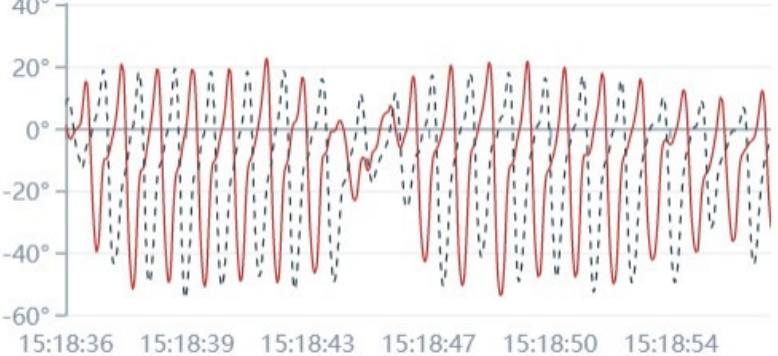
Figure 1. The angle curve of leg flexion and extension in the vertical direction during walking. The red line represents the left leg, and the black dotted line represents the right leg.